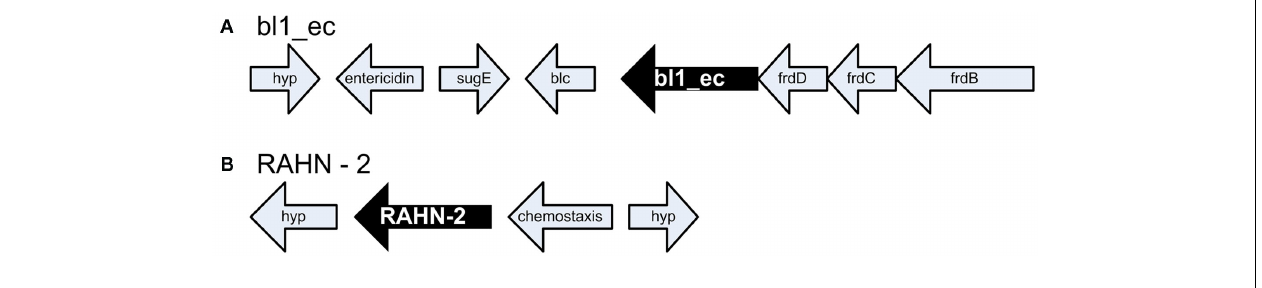
quaternary ammonium compound-resistance protein and hyp. encodes a hypothetical protein (B) bl2be_ctxm. Hyp. encodes two hypothetical proteins adjacent to the β -lactamase RAHN-2 in Rahnella